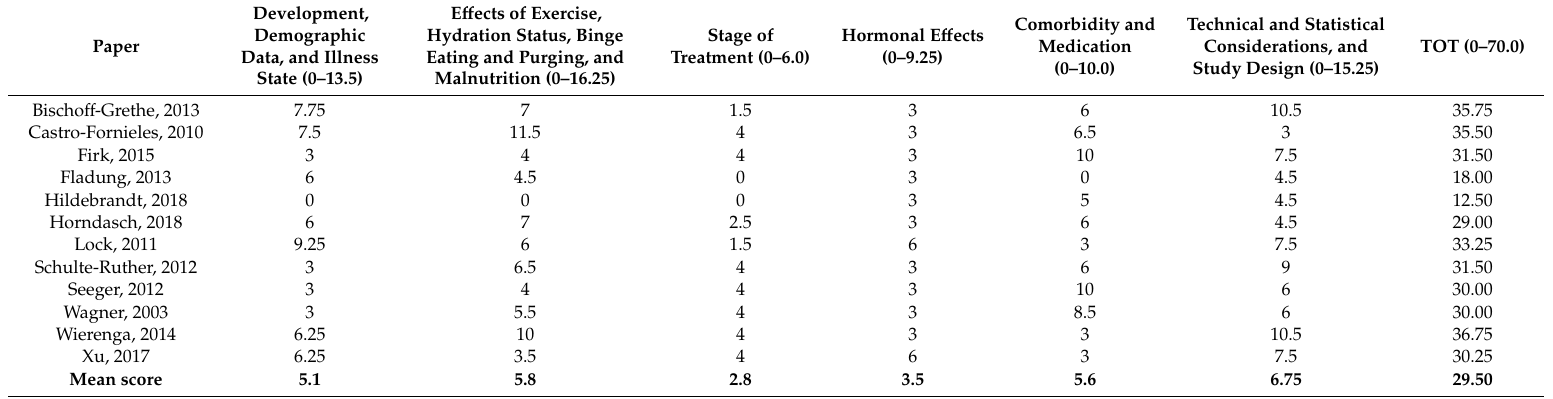
Table 2. Quality assessment of